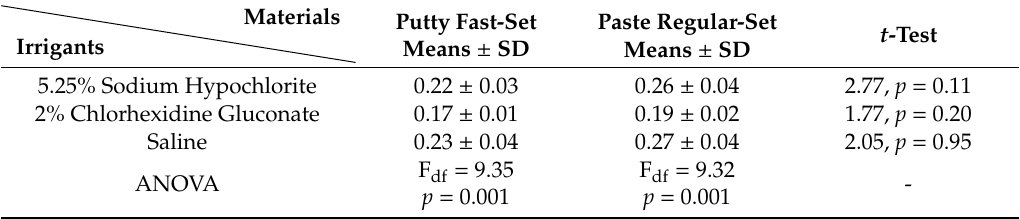
Table 2. Means ± standard deviations of EndoSequence (fast-set putty and regular-set paste) carbonate / phosphate ratio after immersion in di ff erent irrigating